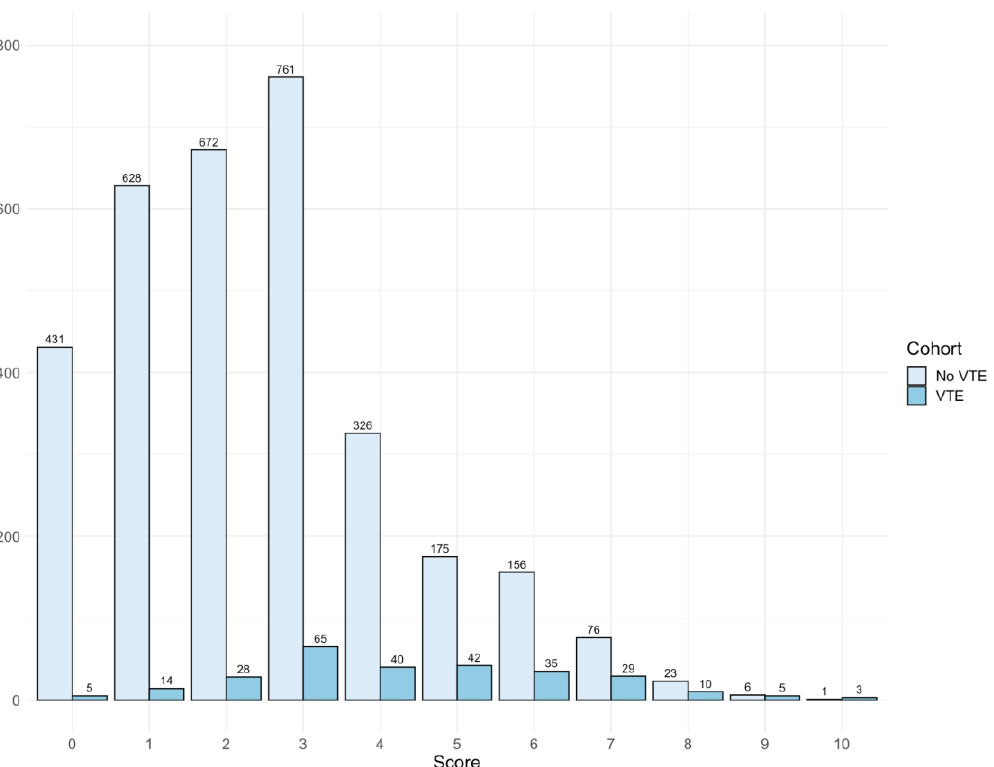
Figure 3. Histogram of risk assessment model score of venous thromboembolism (VTE) and non-VTE groups. The median score is 4 and 2 for VTE and non-VTE group, respectively. Overall, 49.7% scored below 3, whereas 50.4% of VTE patients scored 3 and above.